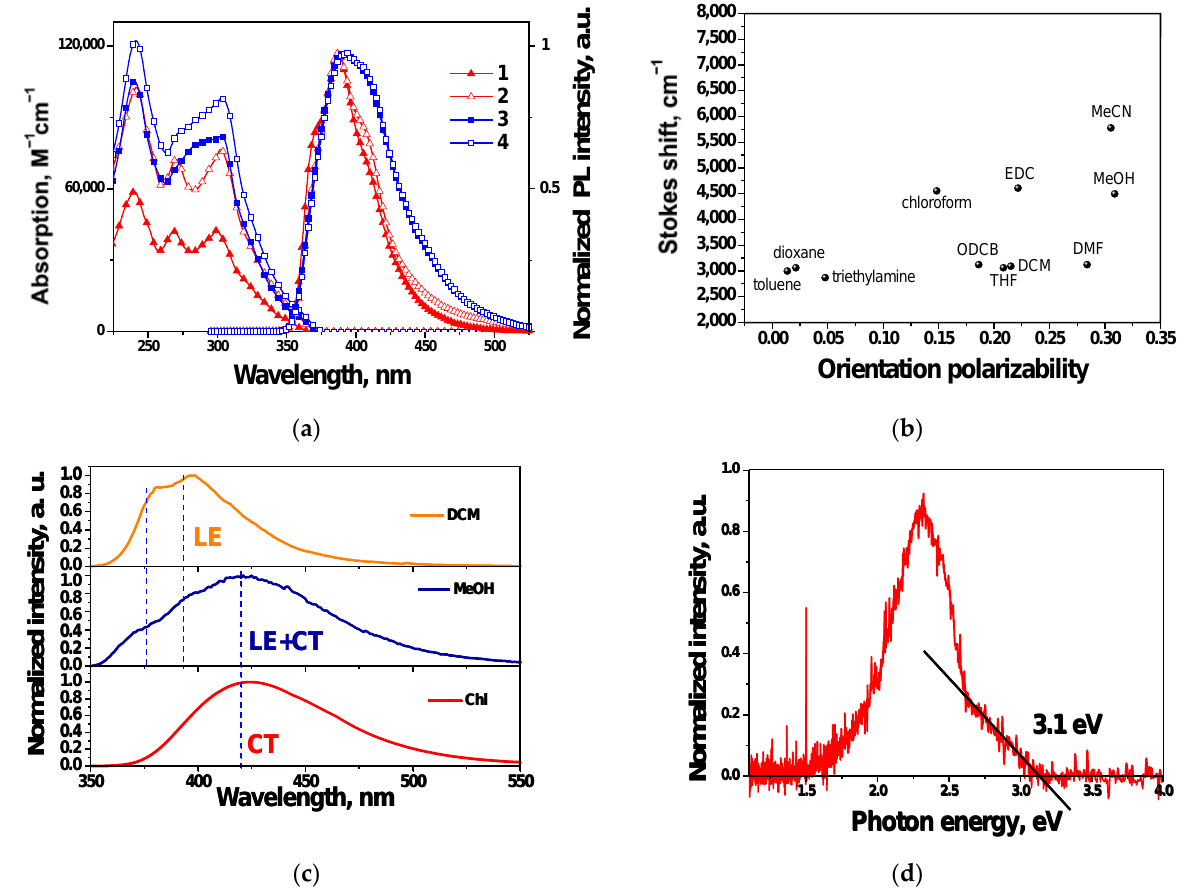
Figure 2. ( a ) Absorption and PL spectra of the dilute THF solutions of 1–4 ; ( b ) the Lippert–Mataga plots for 2; ( c ) PL spectra of the dilute DCM, MeOH and chloroform solutions of 2 ; ( d ) phosphores- cence spectrum of the dilute THF solution of compound 4 recorded at 77 K.